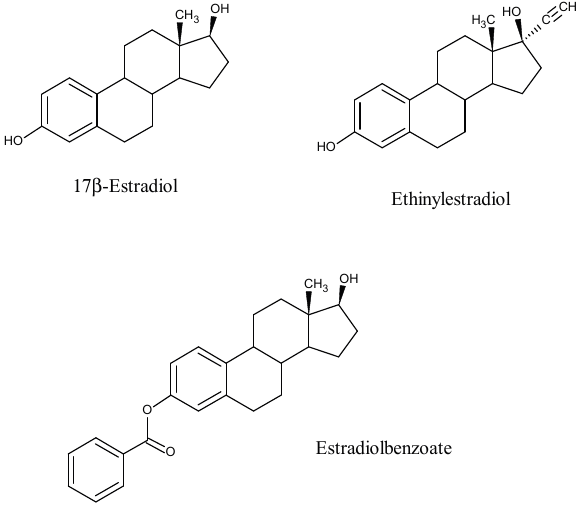
Figure 1. Chemical structures of estradiol (E2), ethinylestradiol (EE2) and estradiol benzoate